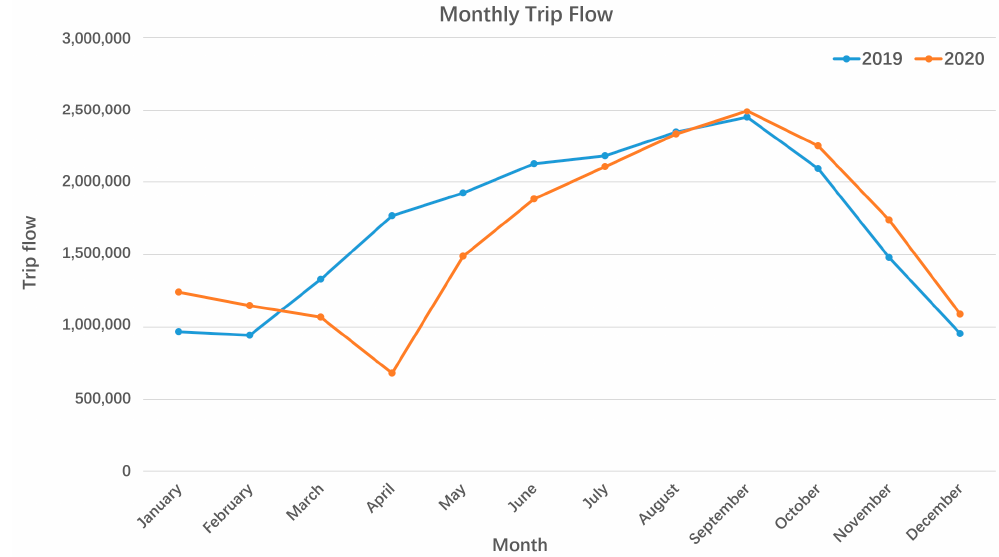
Figure 8. Monthly flows of the bike-sharing system in New York.